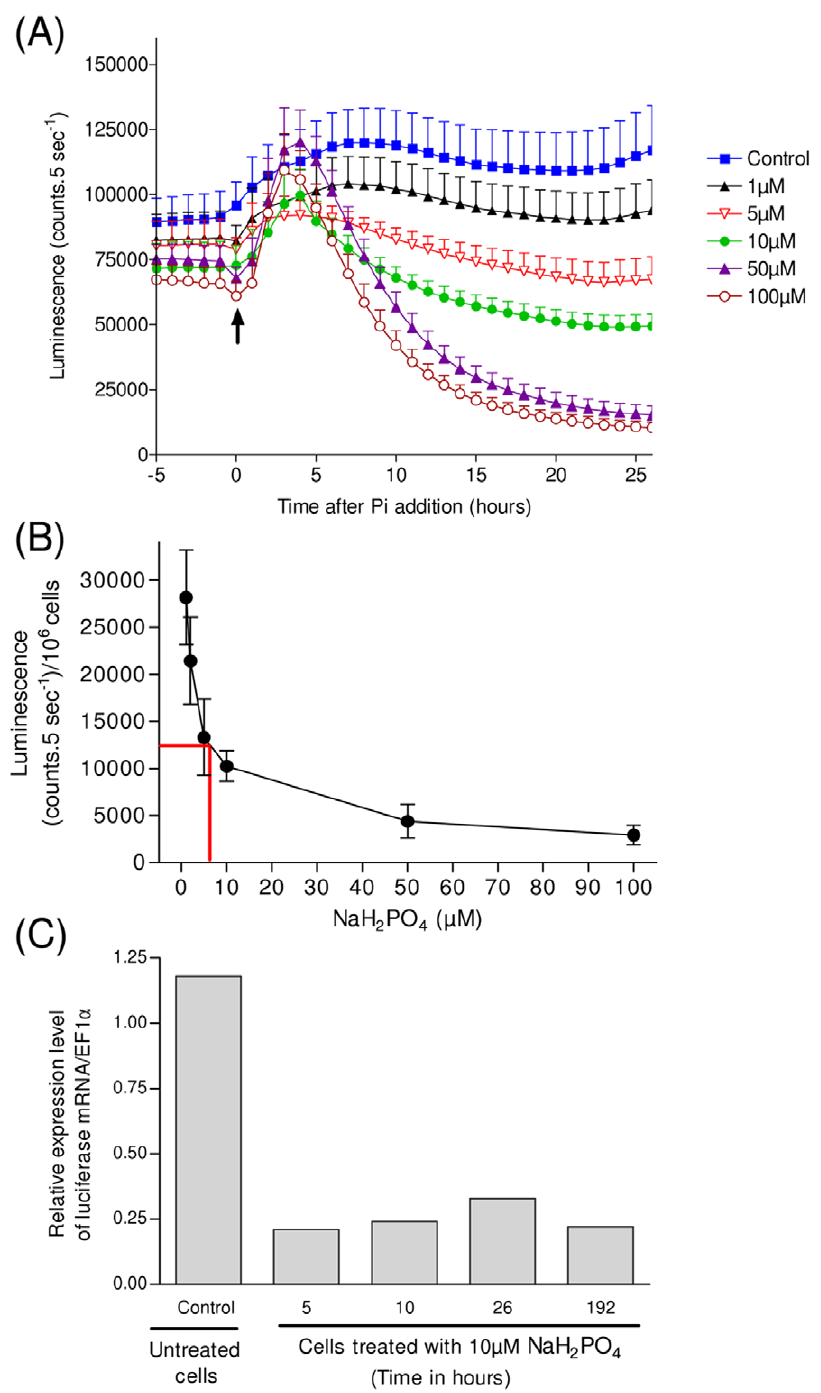
Figure 3. Time-course inhibition of HAPT promoter activity by inorganic phosphate. ( A ) In vivo kinetics of luciferase activity of pHAPT:Luc cells grown in ASW + 10 m M Po before being exposed to various Pi concentrations for 28 hours from time 0. Maximal inhibition was observed for Pi concentrations above or equal to 50 m M (N=3, 6 SD). ( B ) Dose dependent inhibition of pHAPT:Luc in vivo luminescence by inorganic NaH 2 PO 4 . Luminescence measured 28 hours after Pi is reported as a function of Pi concentration. At this time a 50% inhibition is observed for [Pi] , 5 m M (N=3, 6 SD). ( C ) Corresponding luciferase mRNA levels measured at various times after Pi addition at a 50 m M concentration. Transcript amounts were quantified by real time quantitative RT-PCR and normalized to EF1 a . Time 0 corresponds to the time of Pi addition. Control cells were grown in ASW 10 m M Po without Pi.